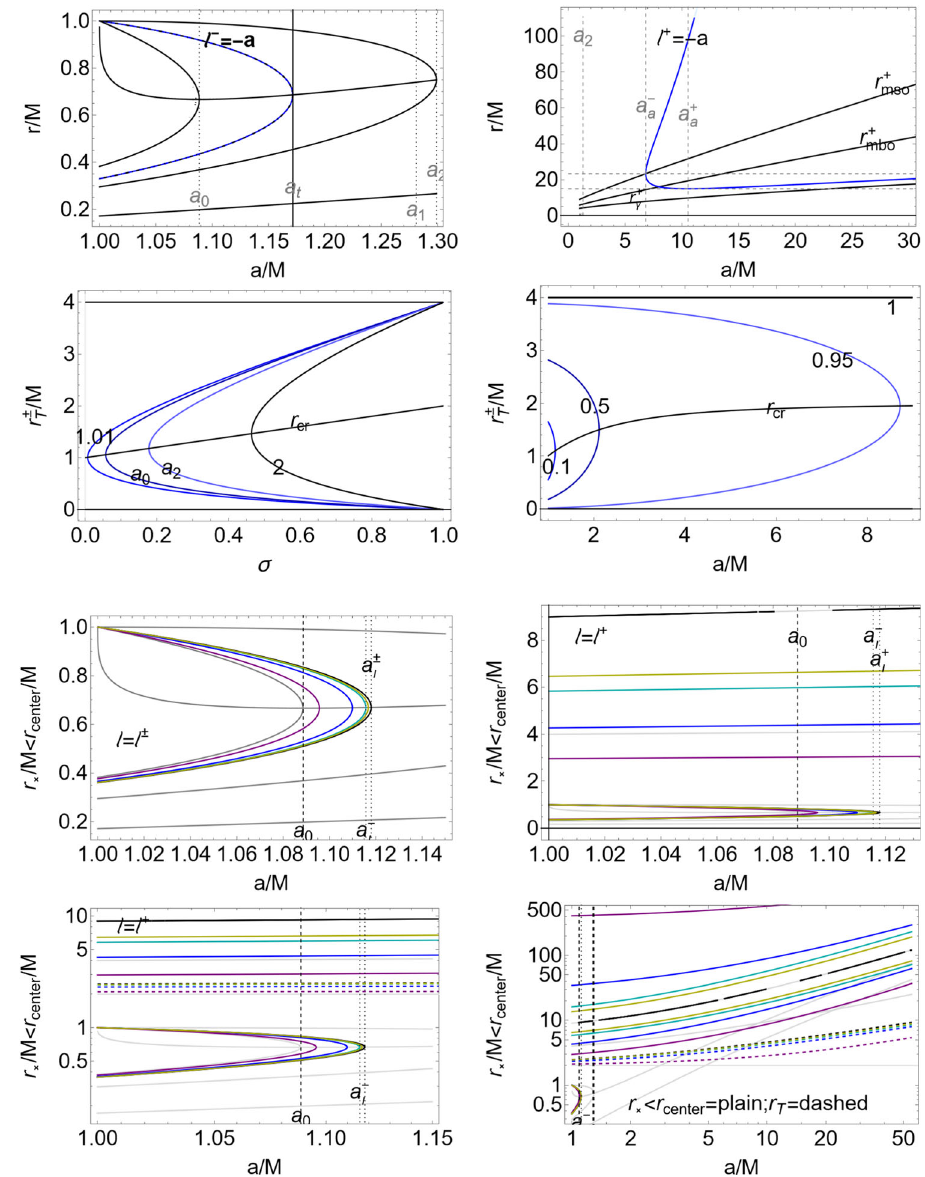
Fig. 19 Gray curves are the NS geodesic structure. Spin a 0 is defined in Table 2 and spins a ± ι in Eq. (11.) The center and inner edge of cusped tori r center > r × (plain curves) and the flow inversion point r (cid:2) (dashed curves), on the equatorial plane σ = 1 are shown as functions of the NS spin – mass ratio for different fluid specific angular momentum according to the colors notation of Fig. 13. (Here the most general solutions r ±